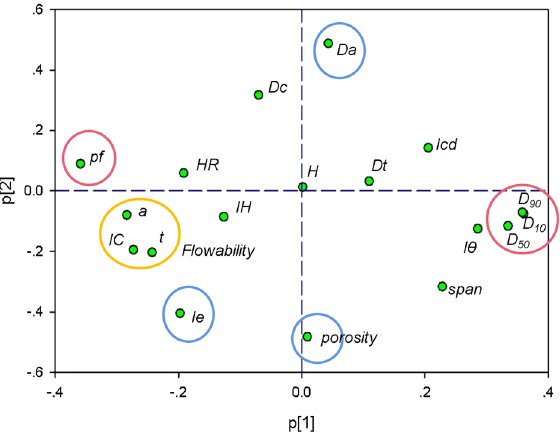
Figure 2. Loading plot of PC1 and PC2. The circles cluster related descriptors and describe the overarching physical property to which they contribute.